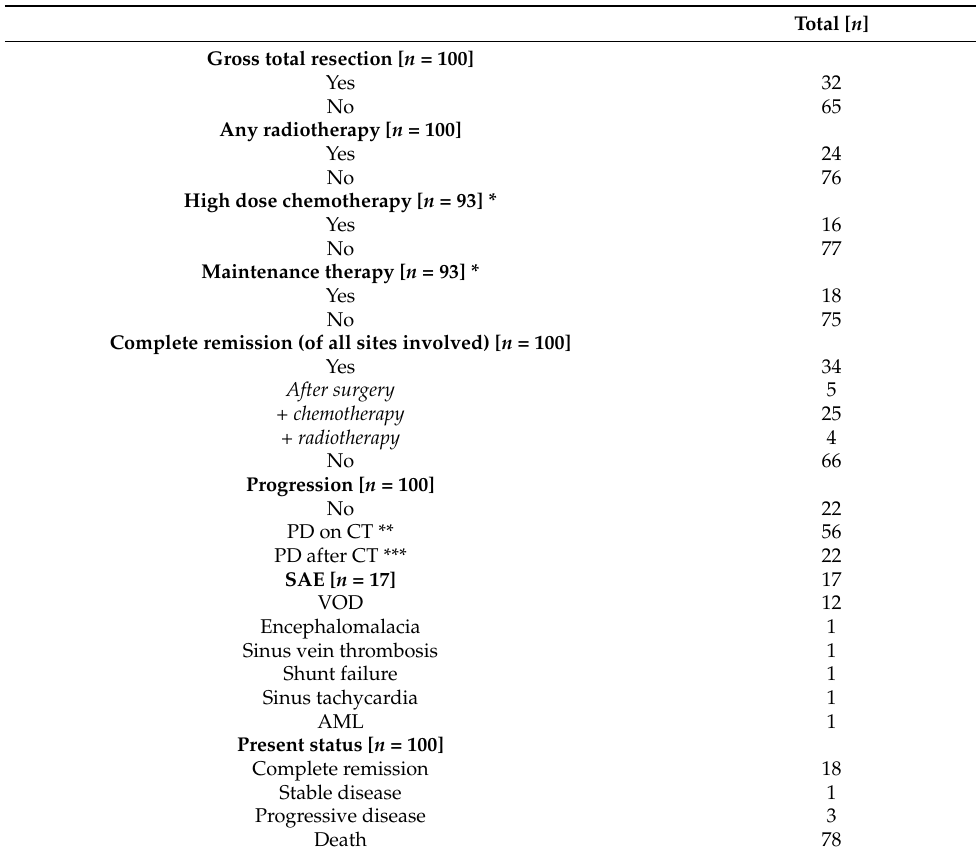
Table 2. Therapy outline and outcome of 100 infants with malignant rhabdoid